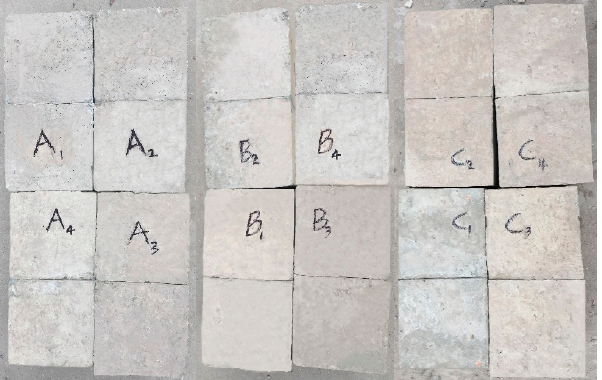
Figure 2. Specimens with initial crack.